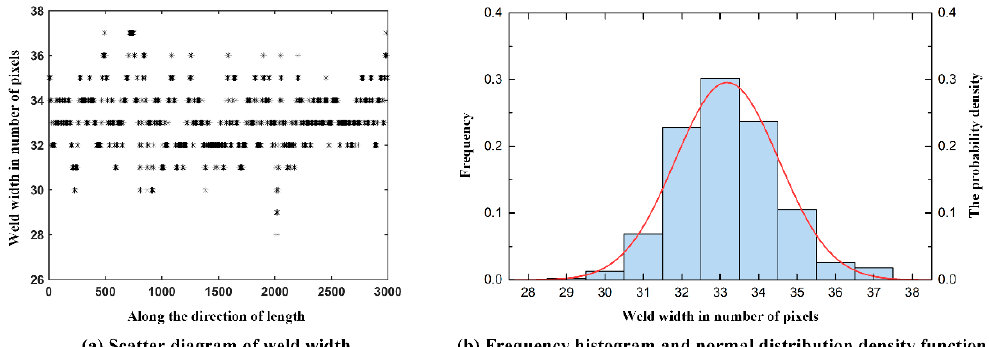
Figure 5. Discretized data of weld width.